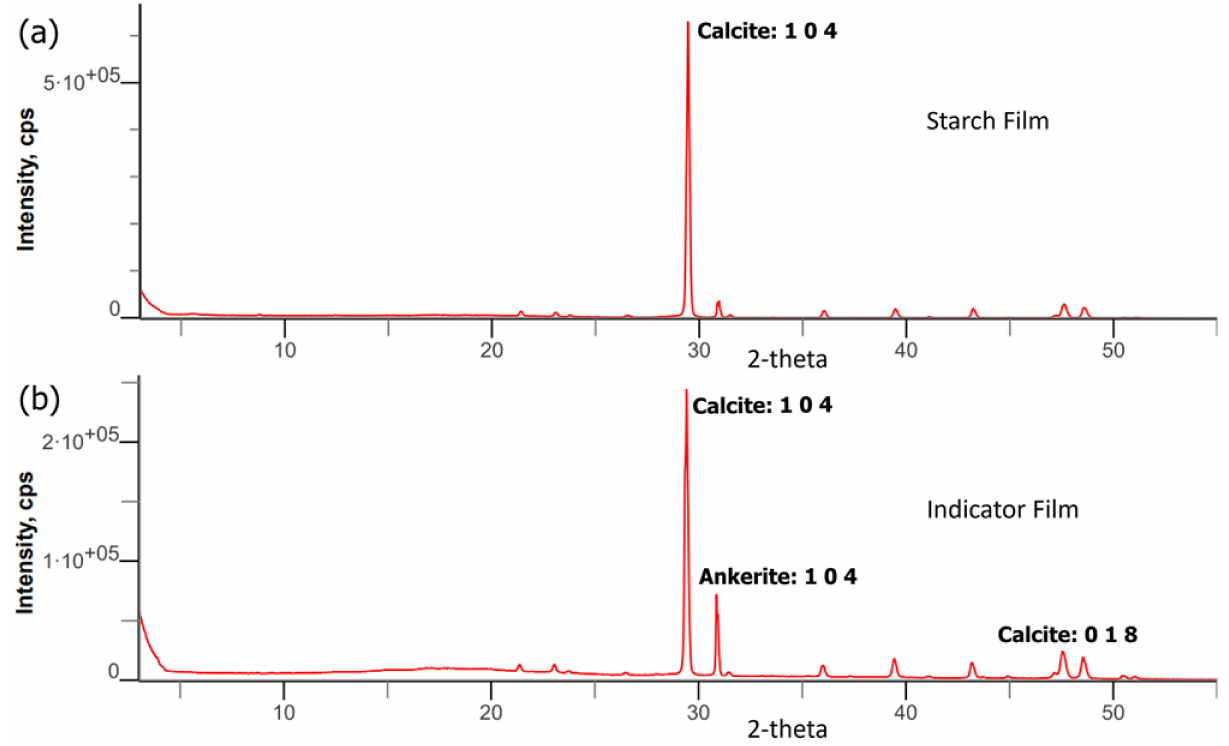
Figure 4. XRD spectra of ( a ) starch film and ( b ) indicator